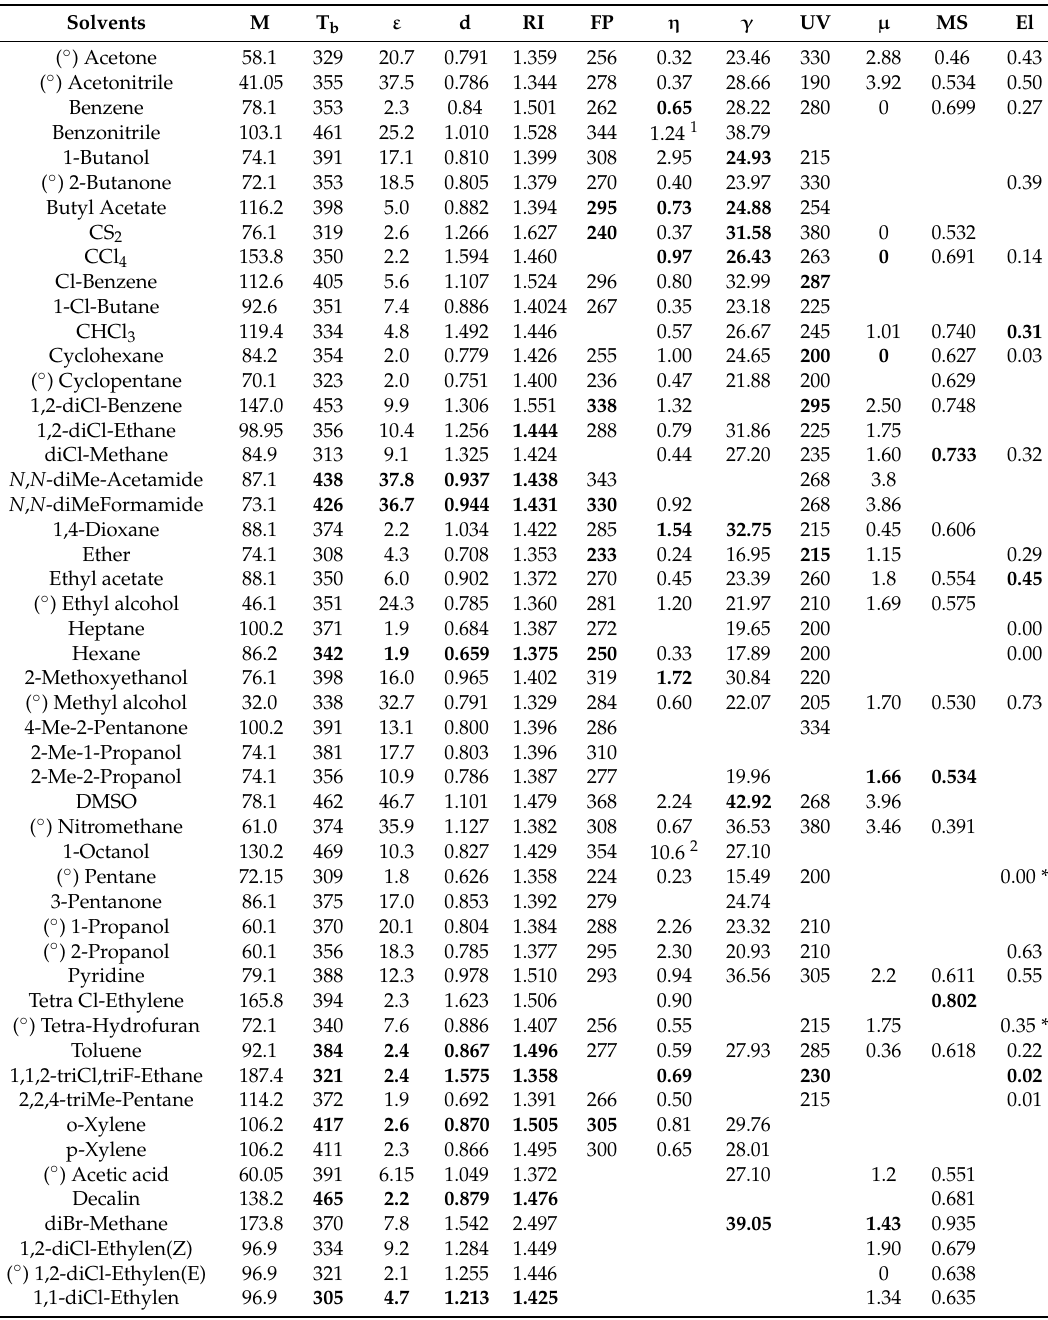
Table 1. Eleven properties of organic solvents with their molar mass M (g · mol − 1 ): T b , boiling point (K); ε , dielectric constant; d, density (at 20 ◦ C ± 5 ◦ C relative to water at 4 ◦ C, g/cc); RI, refractive index (20 ◦ C); FP, Flashpoint (K); η , viscosity (Cpoise, 20 ◦ C; 1 at 25 ◦ C, 2 at 15 ◦ C); γ , surface tension (mN/m at 25 ◦ C); UV, Cutoff UV values (nm); µ , dipole moments in debye (1D = 10 − 18 esu cm = 3.3356 × 10 − 3 C m); MS, magnetic susceptibility (also, − χ · 10 6 , in emu mol − 1 , 1 emu = 1 cm 3